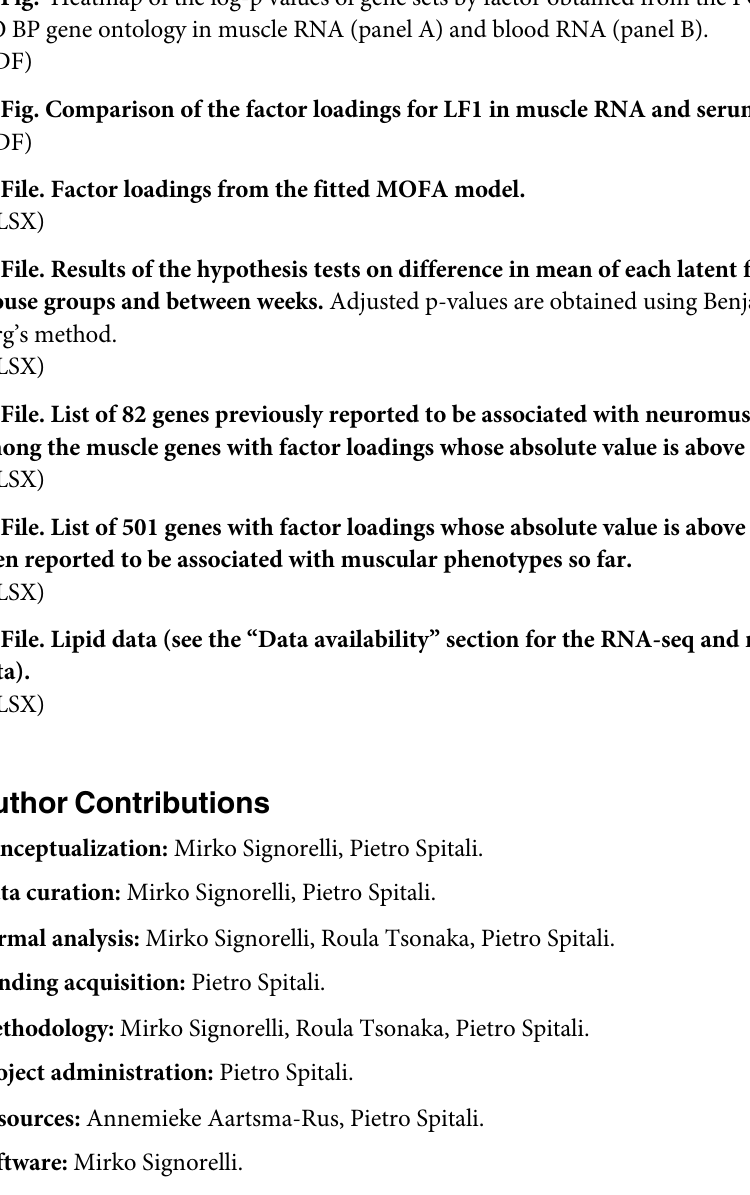
S5 Fig. Expression levels of Col6a1 , Col6a2 and Col6a3 across mice groups in the muscle RNA-seq view. S6 Fig. Principal component gene set enrichment analysis of LF1 in blood RNA (panel A),